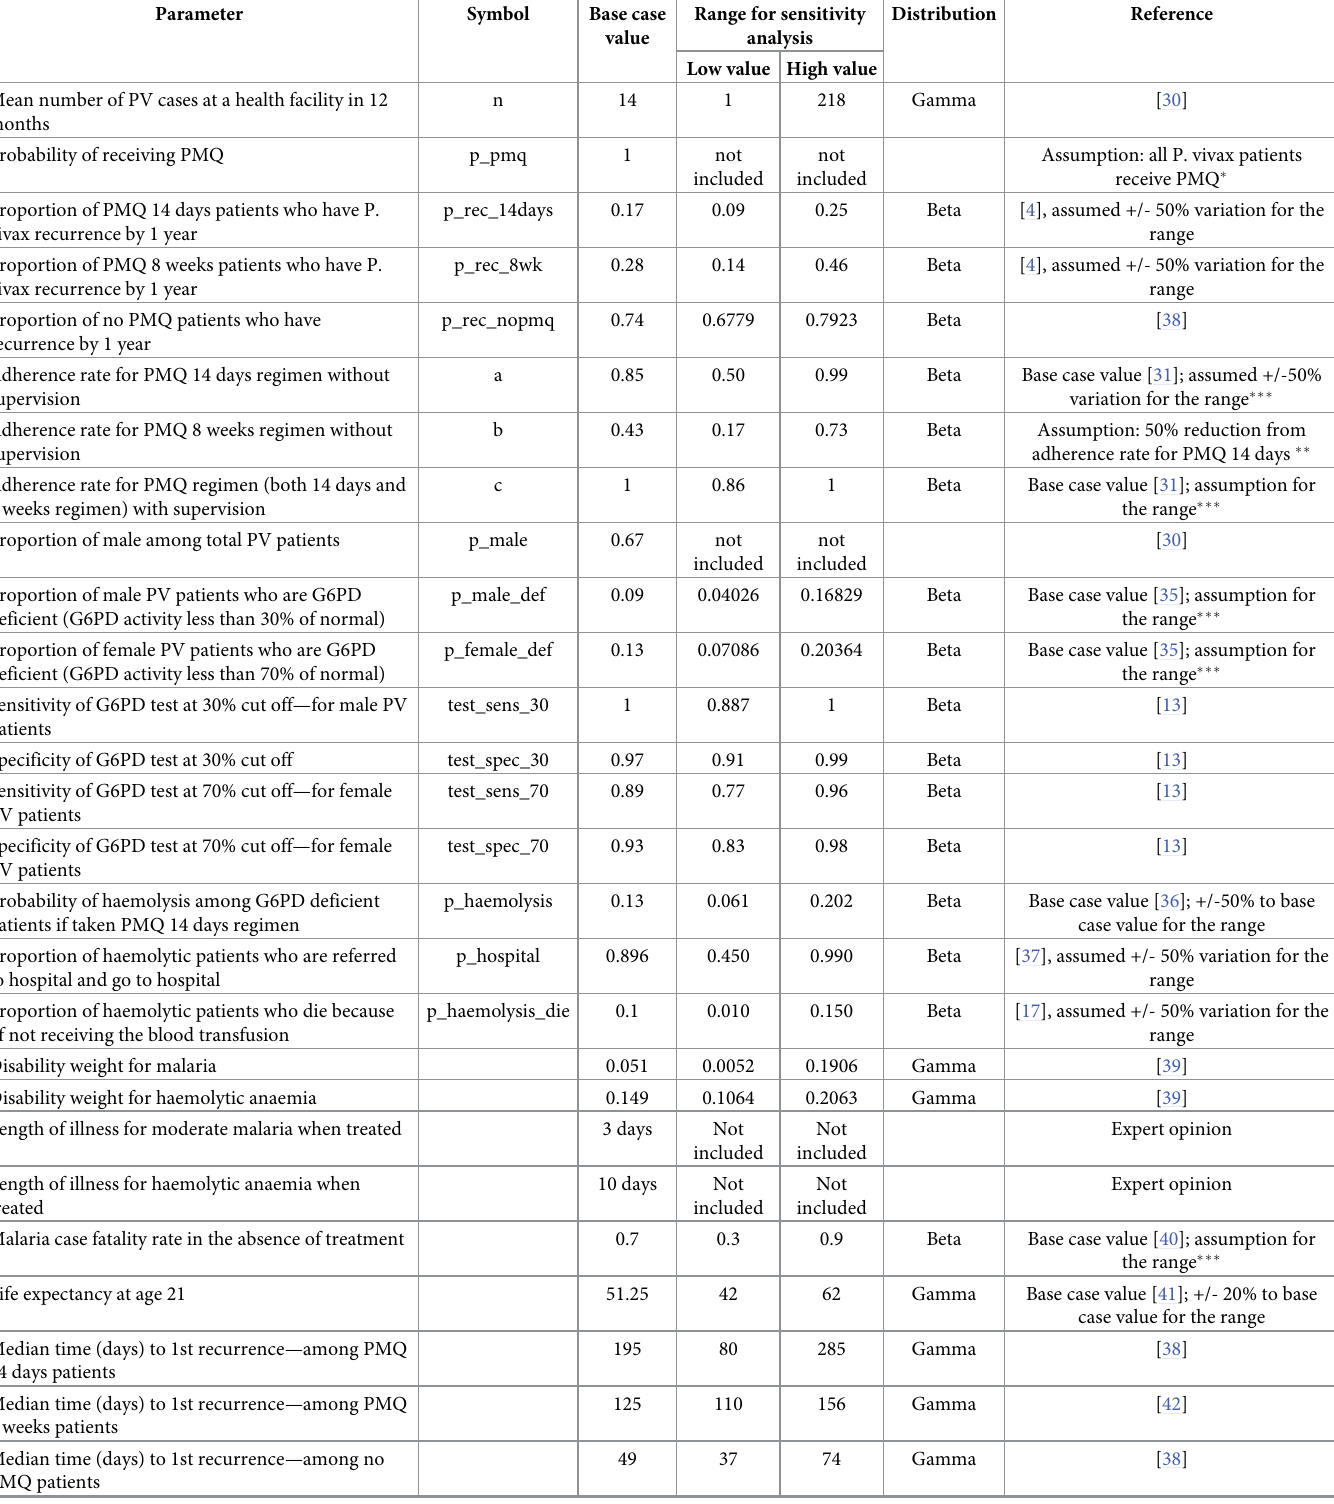
Table 1. Parameter for effect measures included in the decision tree